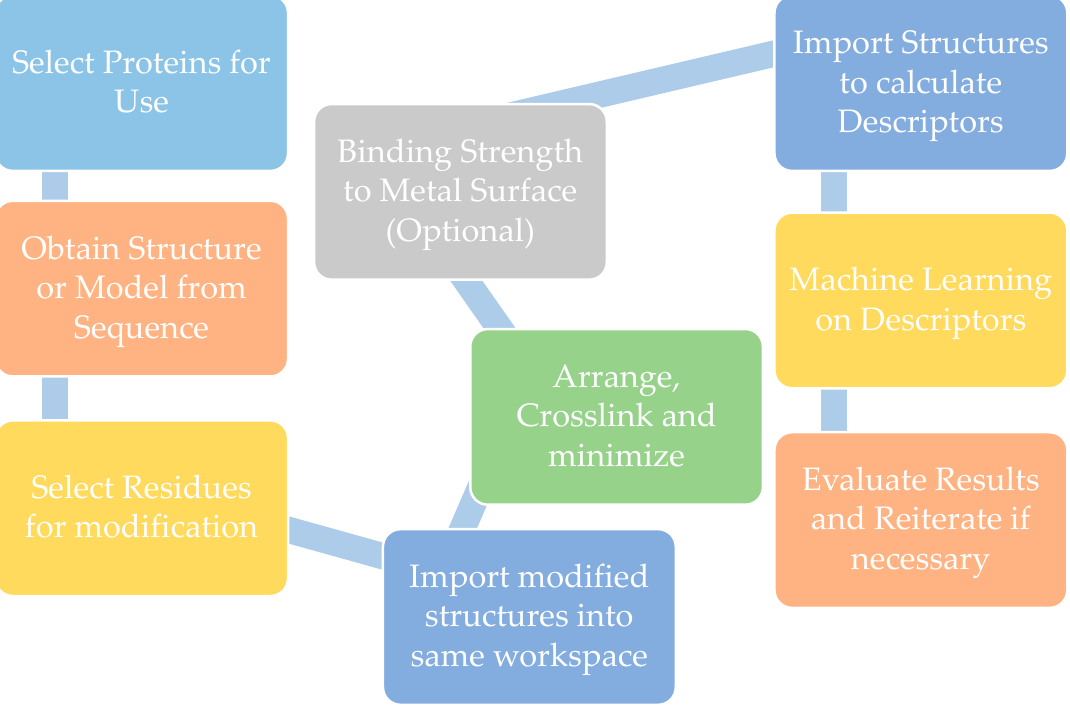
Figure 4. Prediction of antibacterial activity using multiple regression on 421 descriptor set.